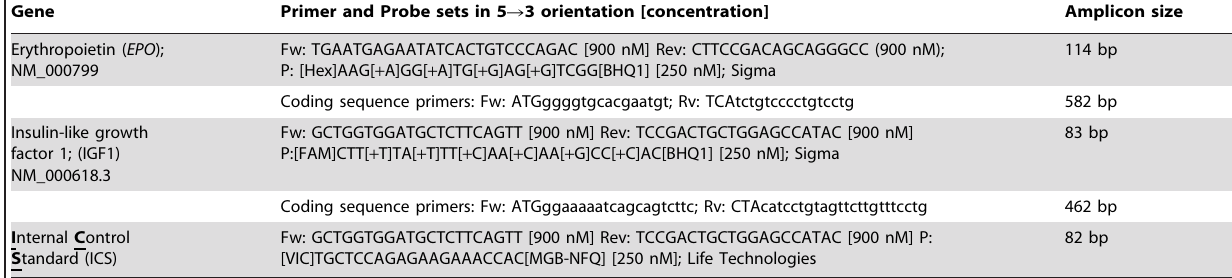
Gene Primer and Probe sets in 5 R 3 orientation [concentration]